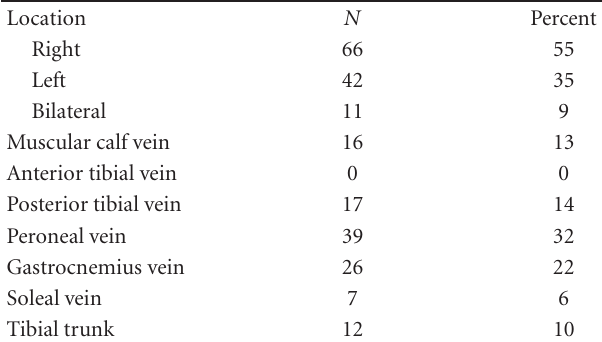
Table 3: Location of calf